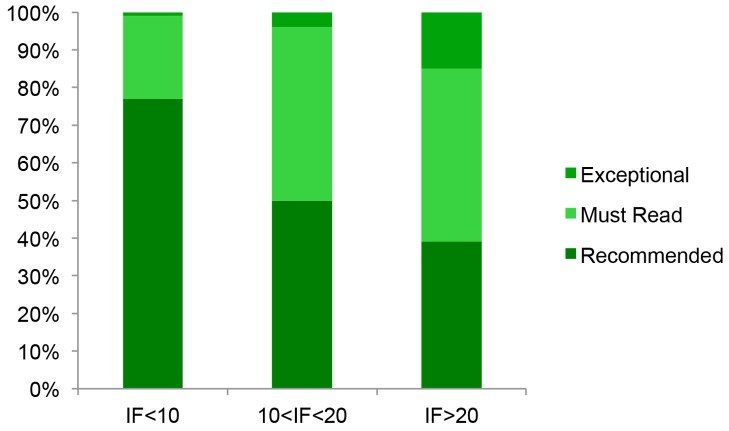
The proportion of papers, with between 90 and 110 citations in the F1000 dataset, scored in each category as a function of the IF of the journal in which the paper was published.The numbers of papers in each category are 131, 194, and 128 for IF<10, 10<IF<20, and IF>20, respectively.